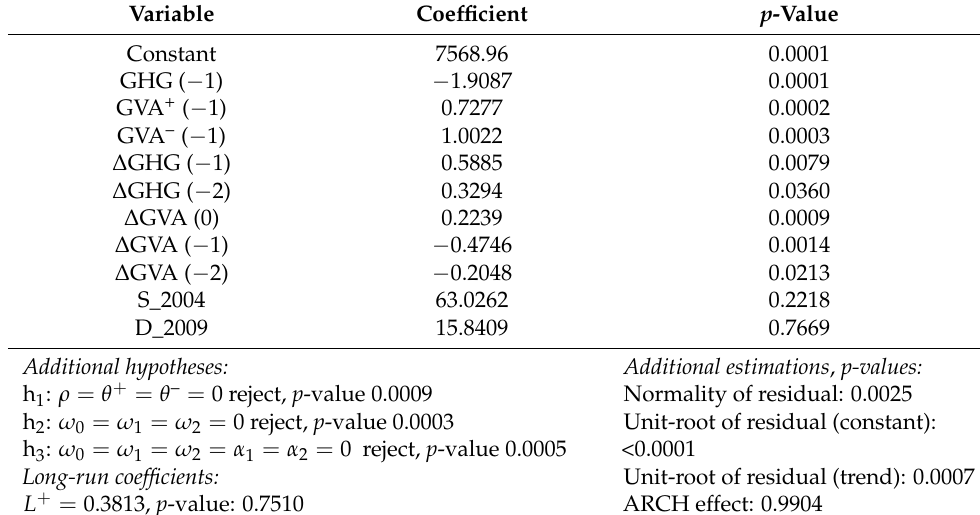
Table 4. Nonlinear autoregressive distributed lag (NARDL) results for Lithuania. Variable Coefficient p -Value